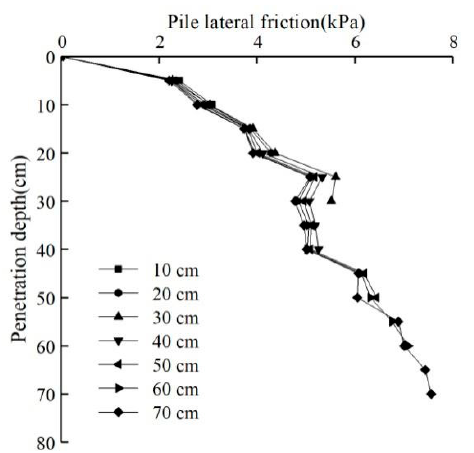
Figure 13. The relationship between the lateral friction and penetration depth at different pile pressing depths.